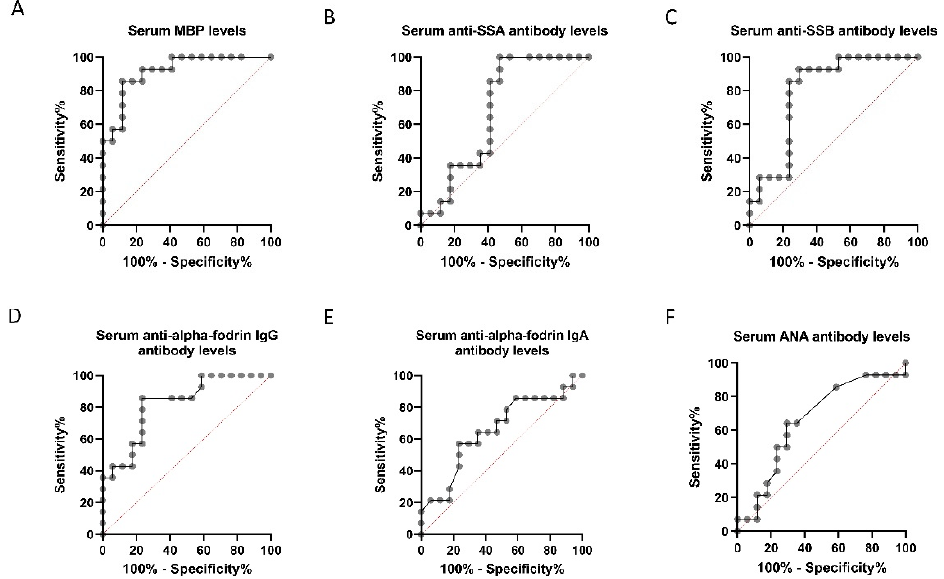
Figure 7. Receiver operating characteristic (ROC) curve plot for discrimination between control and normal-tension glaucoma (NTG) patients. ROC curves for serum and myelin basic protein (MBP) concentration ( A ), anti-Sjögren’s- syndrome-related antigen A (SSA) antibody level ( B ), anti-Sjögren’s-syndrome-related antigen B (SSB) antibody level ( C ), anti- α -fodrin IgG/IgA antibody level ( D , E ) and ANA level ( F ) are shown. The area under the curve for the serum MBP level was the largest.